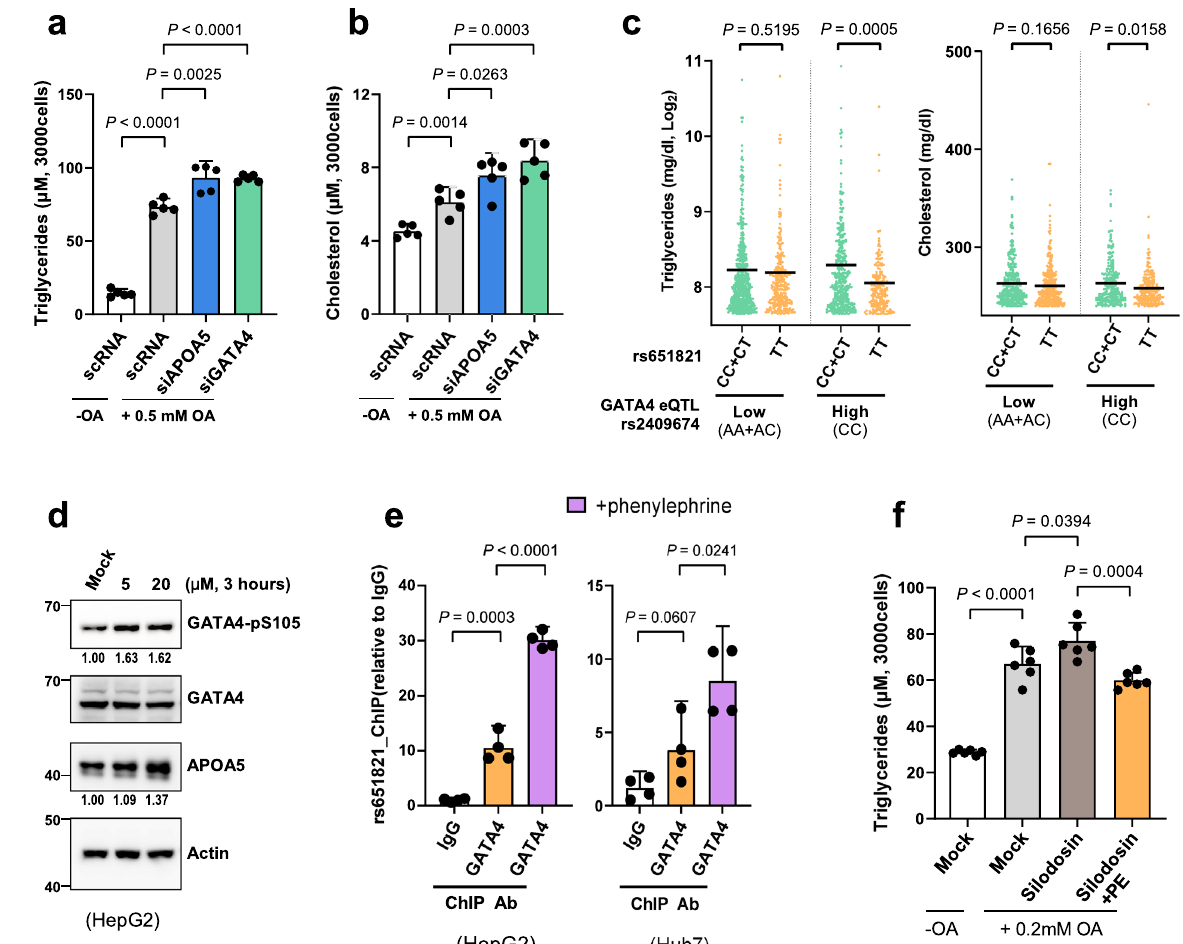
Fig. 5 Regulatory role of GATA4 in cellular and plasma TG homeostasis. a , b Quanti fi cation of TG ( a ) or TC ( b ) level in HepG2 cells treated with or without oleic acid (OA). P values and 95% CIs are indicated, and independent measurements of n = 5 are plotted. c Data for participants with plasma TG ≥ 200 mg/dl (left) and plasma TC ≥ 240 mg/dl (right) were retrieved from the TWB cohort and sequentially strati fi ed by the rs2409674 and rs651821 genotypes. Mean values are indicated. Statistical difference between two groups was determined by the Student ’ s t test. d Immunoblot showing APOA5 expression and phosphorylation of GATA4 at serine 105 following treatment of HepG2 cells to phenylephrine. All blots derive from the same experiment and were processed in parallel. e Histogram showing the relative rs651821 site enrichment after ChIP with normal mouse IgG or anti-GATA4 using HepG2 and Huh7 cells treated with or without 20 μ M phenylephrine for 3 h. f Quanti fi cation of OA-induced TG level in HepG2 cells co-treated with or without 10 nM silodosin and 20 μ M phenylephrine. P values and 95% CIs are indicated, and independent measurements of n = 6 are